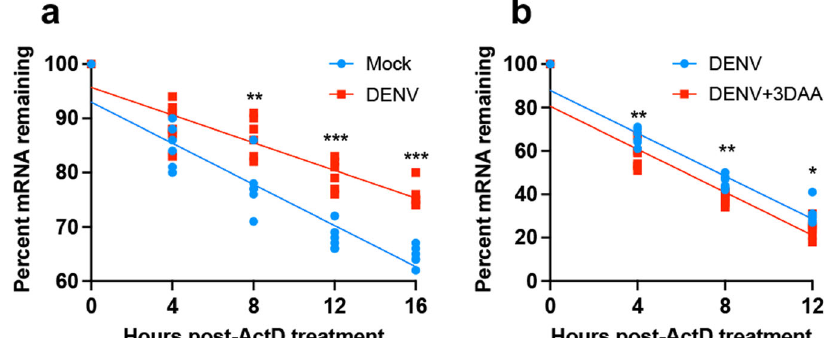
Fig. 9 DENV infection promotes Ubc9 RNA stability. a Measurement of Ubc9 RNA in mock and DENV-infected Aag2 cells. At 72 hpi, cell culture medium was replaced with medium containing 1 μ M ActD. RNA was collected at the indicated times post-treatment and subjected to RT-qPCR to determine remaining relative RNA levels. ** p < 0.01; *** p < 0.001 ( t -test). b Measurement of Ubc9 RNA in m 6 A DENV-infected m 6 A-inhibited Aag2 cells with 3-DAA. At 72 hpi, cell culture medium was replaced with medium containing 3-DAA. After 24 h post treatment, cell culture medium was replaced with medium containing ActD. RT-qPCR was used to measure the remaining relative RNA levels * p < 0.05; ** p < 0.01 ( t Protein G Dynabeads (Thermo Fisher) per sample was washed three times in MeRIP buffer (150mM NaCl, 10mM Tris-HCl [pH 7.5], 0.1% NP-40), and incubated with 1 μ L anti-m 6 Aantibody(SynapticSystem)for2hat4°Cwithrotation.Afterwashing three times with MeRIP buffer, anti-m 6 A conjugated beads were incubated with puri fi ed mRNAs with rotation at 4°C overnight in 300 μ L MeRIP buffer with 1 μ L RNase inhibitor (recombinant RNasin; Promega). Ten percent of the mRNA sample was saved as the input fraction. Beads were then washed twice with 500 μ L MeRIP buffer,twicewith lowsalt wash buffer (50mMNaCl,10mMTris-HCl [pH7.5],0.1% NP-40), twice with high salt wash buffer (500mM NaCl, 10mM Tris-HCl [pH 7.5], 0.1% NP-40), and once again with MeRIP buffer. m 6 A-modi fi ed RNAs were eluted ethanol precipitation. RNA samples were submitted to Genewiz for RNA sequencing with Illumina Hiseq PE150. Three replicates were submitted per sample (IP and input), totalling 12 samples.